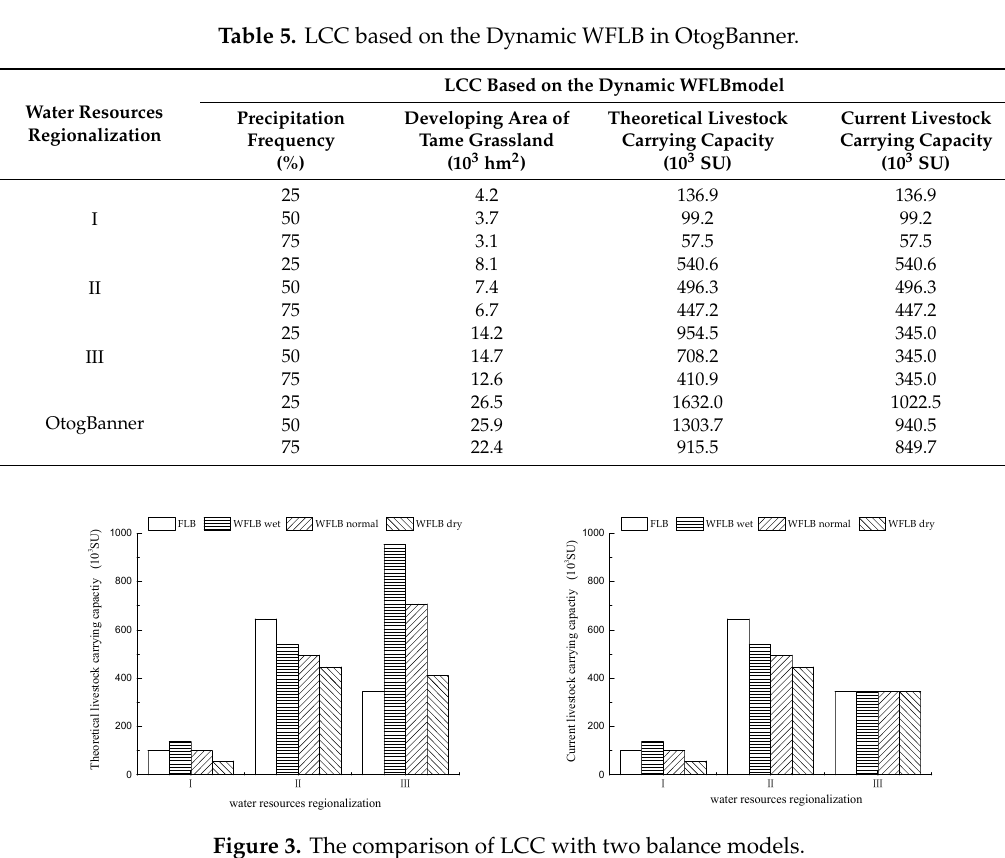
Table 6. Analysis of stocking capacity balance based on dynamic FLB.